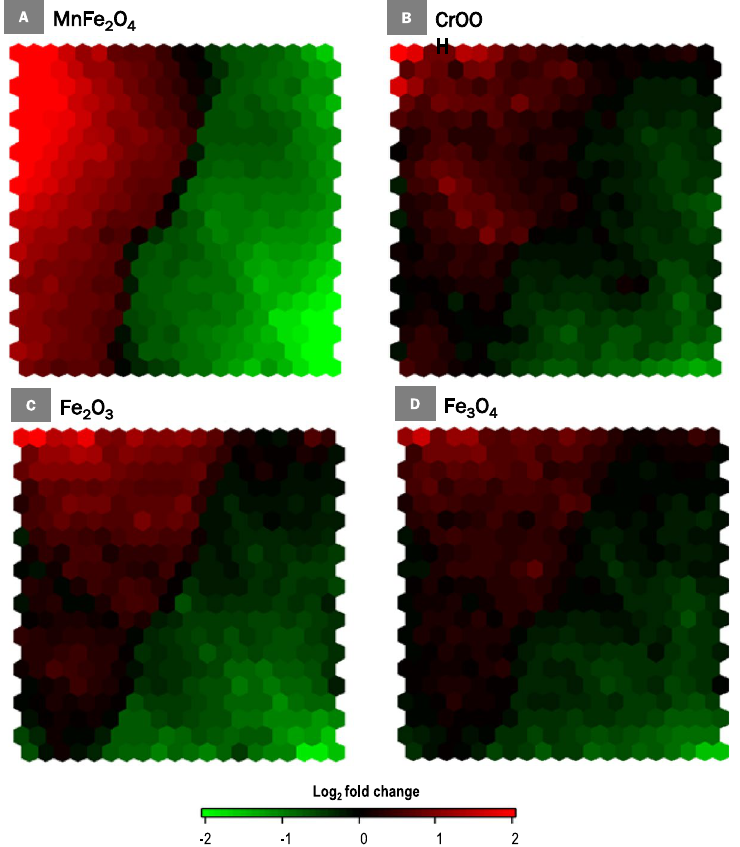
Figure 1. Self-organizing map of differentially expressed genes (N = 2164). Self-organizing map of differentially expressed genes based on fold-changes and shown by nanoparticle: ( A ) MnFe 2 O 4 , ( B ) CrOOH, ( C ) Fe 2 O 3 and ( D ) Fe 3 O 4 . Each cell of the map represents a set of genes with overall similar differential gene expression and increasing distance between cells indicates increasingly different expression